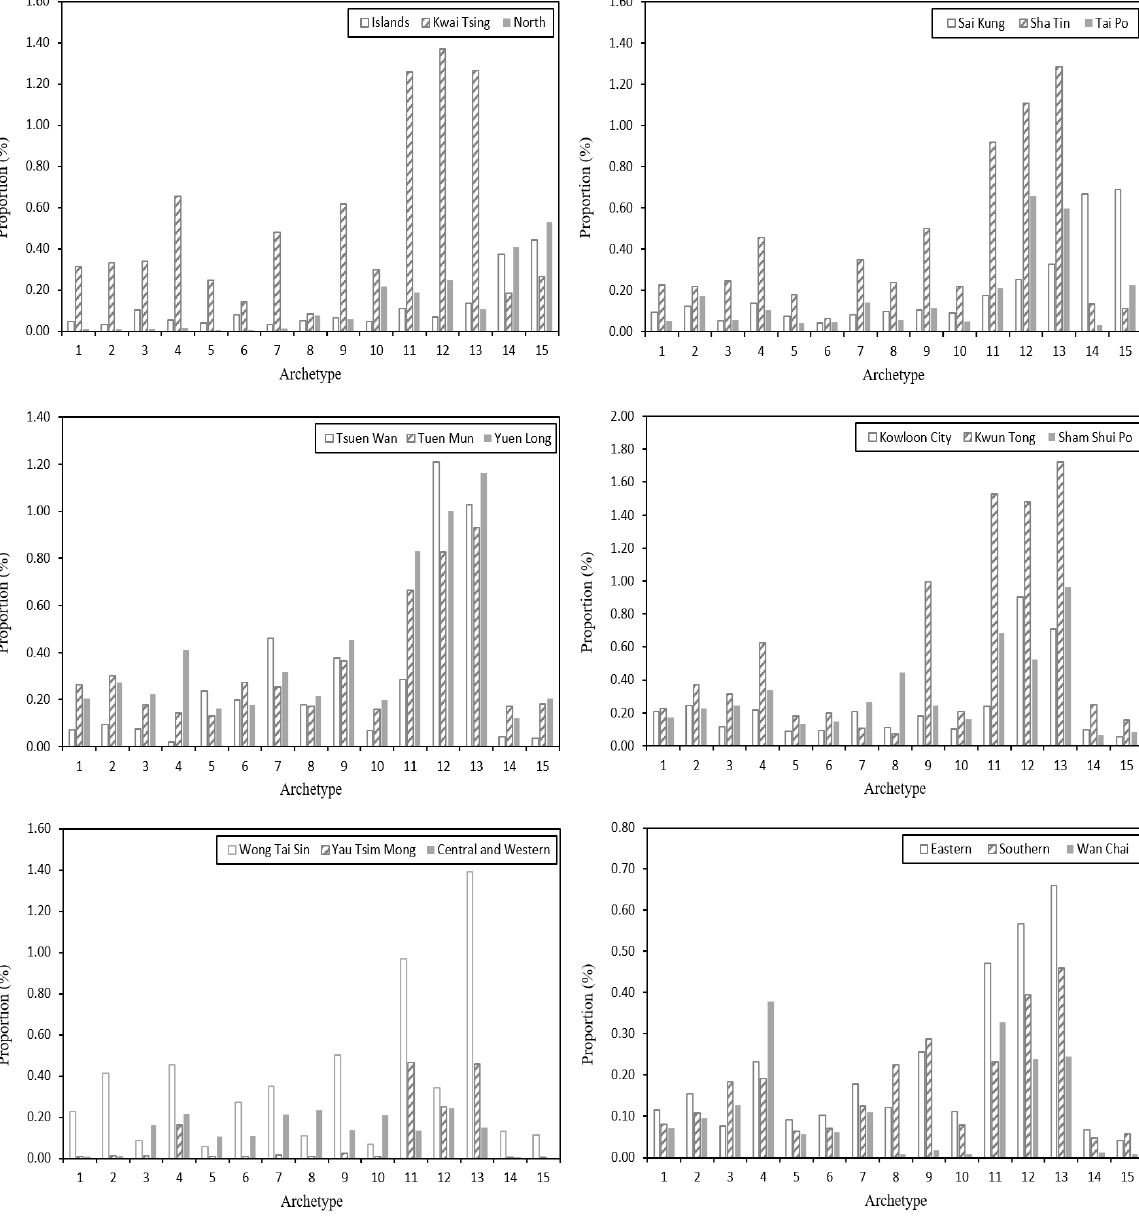
Figure A1. The proportion of individual archetypes in the housing stock, broken down by district.